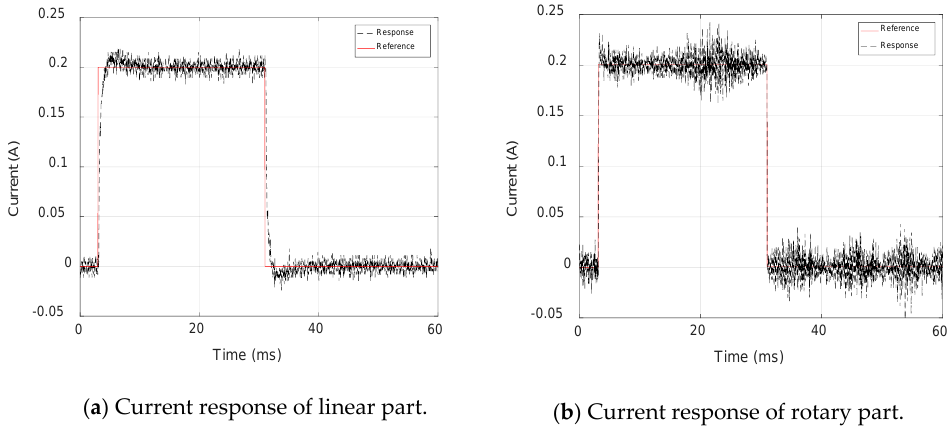
Figure 16. Current loop responses of the motor when the reference is 0.2 A.